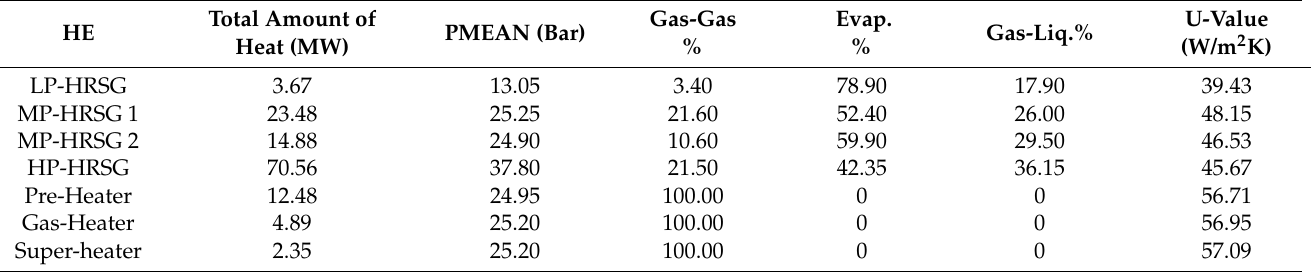
Table 1. Calculated U-Values for different heat exchanger in SMR X95